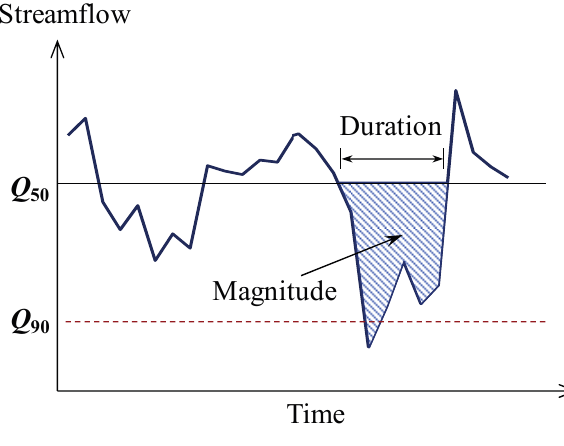
Figure 2. Definition of streamflow